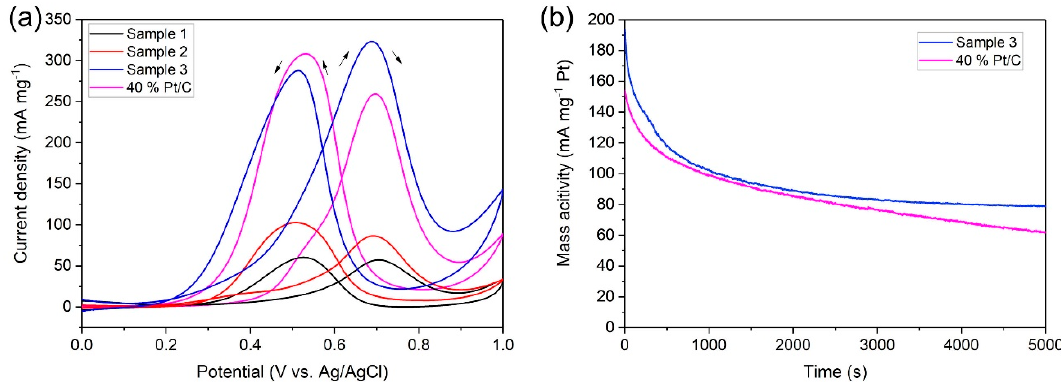
Figure 7. ( a ) CV curves of Pt nanocluster-anchored hollow Ag-Au nanostructures with injected molar ratios of Pt / Au at 1 (black line), 2 (red line) 3 (blue line) and commercialized 40% Pt / C catalysts (purple lien) recorded in N 2 -saturated 1 M CH 3 OH + 0.5 M H 2 SO 4 solution. ( b ) Chronoamperometric curves of Pt / Au at 3 (blue line) and commercialized 40% Pt / C catalysts (purple lien) recorded at 0.70 V (vs. Ag / AgCl) in N 2 -saturated 1 M CH 3 OH + 0.5 M H 2 SO 4 solution.